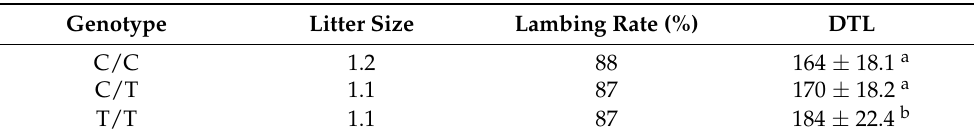
Table 2. Litter size, fertility rate, and days to lambing (DTL) for each genotype at SNP20/SNP21. Data are expressed as LSmeans.